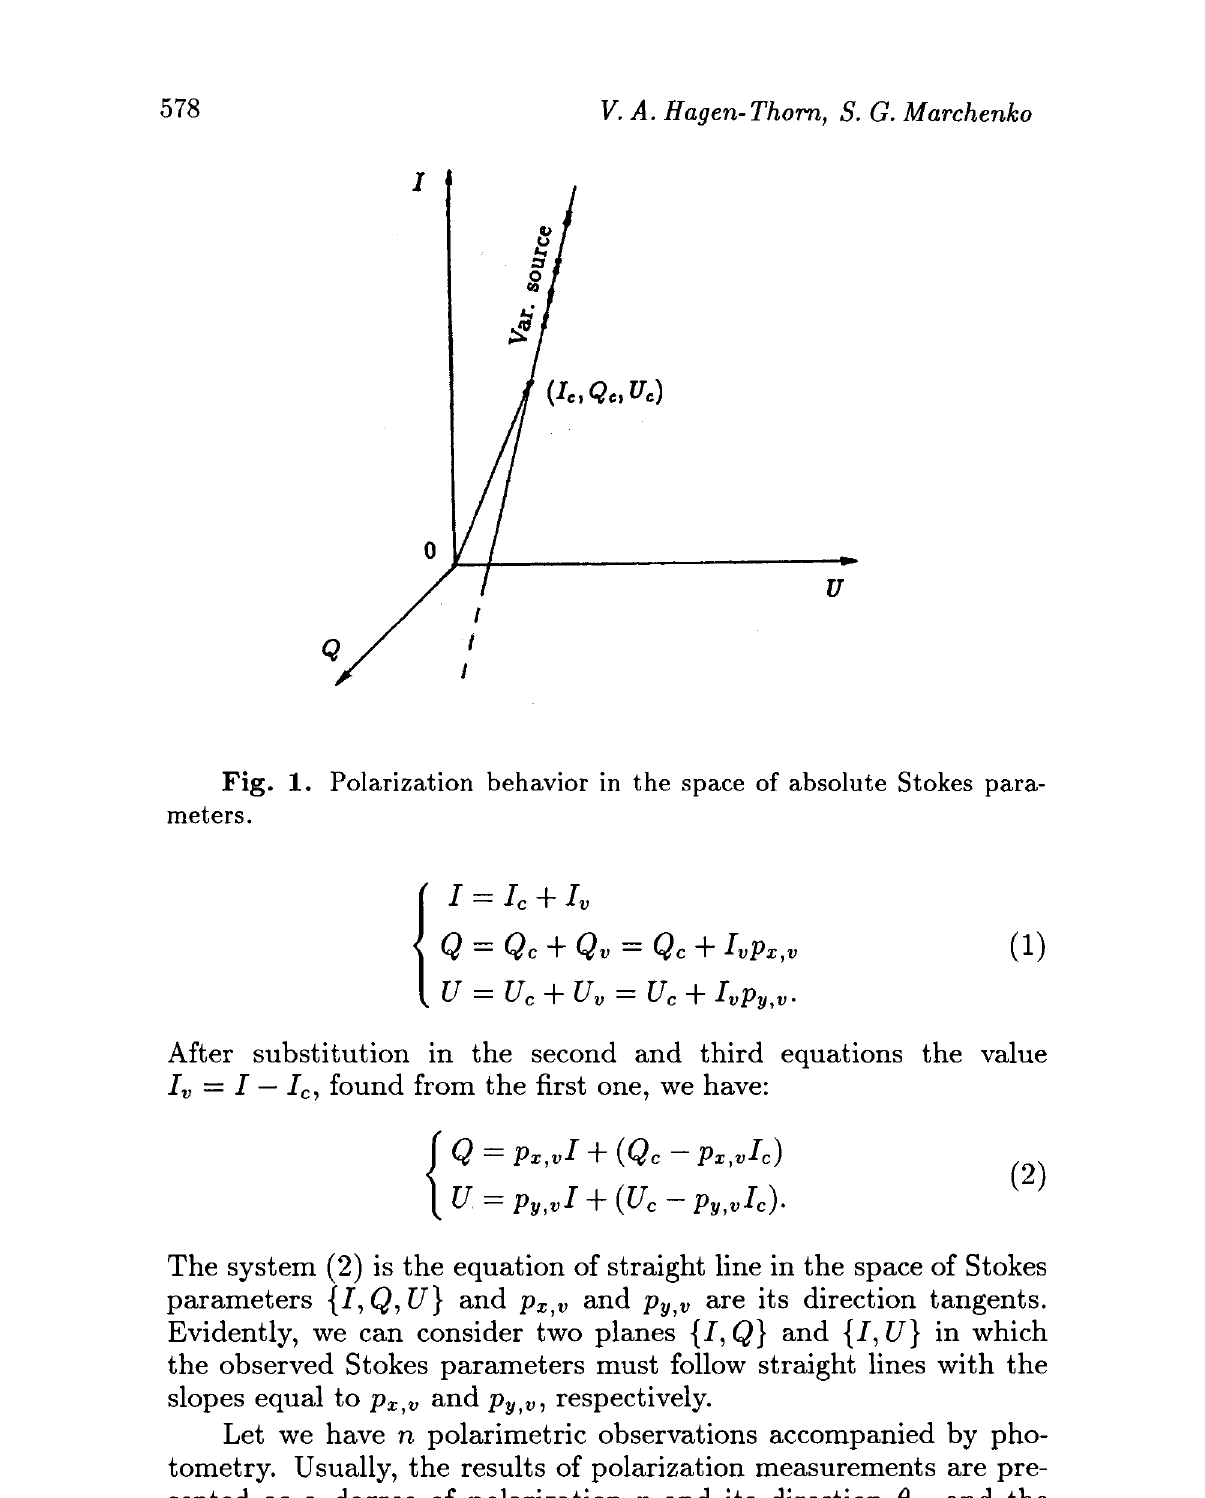
Fig. 1. Polarization behavior in the space of absolute Stokes para-